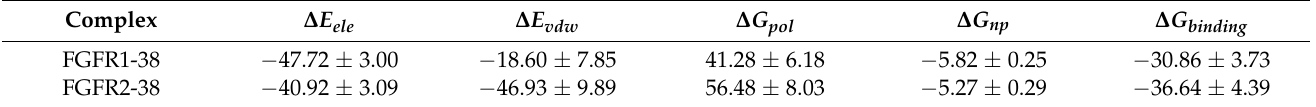
Table 2. Binding free energies (kcal/mol) of FGFR1-38 and FGFR2-38 systems computed by the MM-GBSA